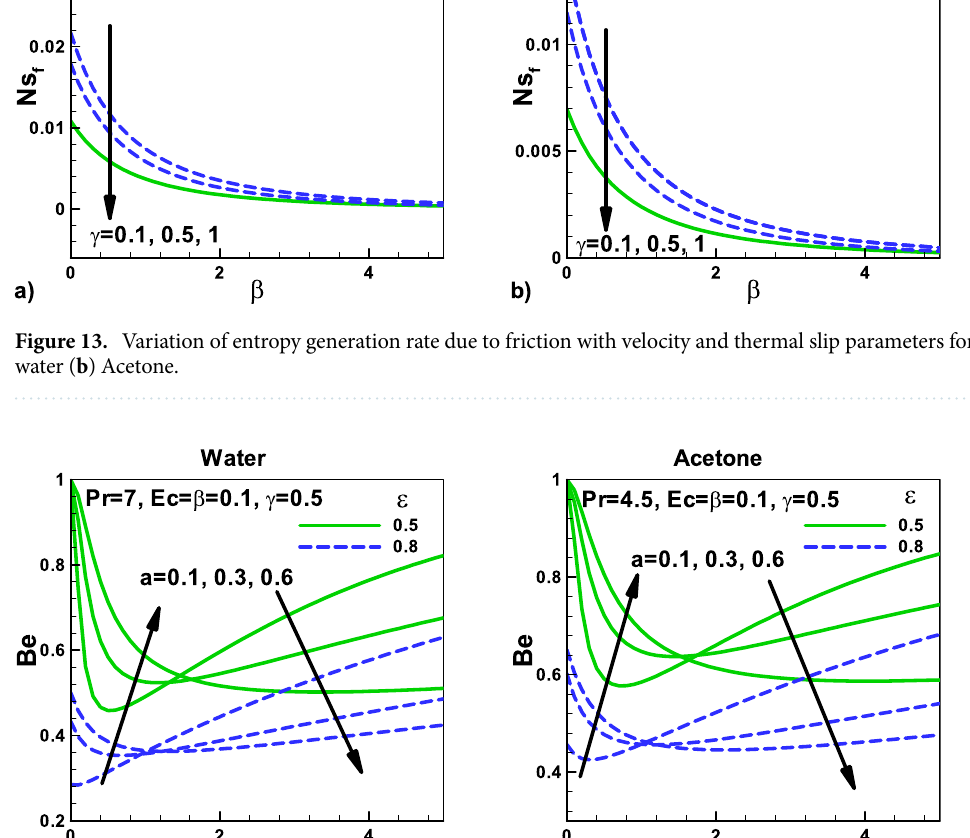
total entropy generation rate N sh are also increasing, as displayed in Fig. 10 for water and acetone, respectively. Eckert number Ec also produces heating effects that increase the temperature gradients and increase the entropy generation rates N sh . Figure 12: The variation of entropy generation rate due to fluid friction with magnetic parameter M and needle size a for (a) water (b) acetone. The effect of variation in composite velocity and the increase in the size of the needle will increase entropy generation due to fluid friction. The impact of Eckert number Ec on the total entropy generation rate N sf is also displayed with thermal slip parameter and with velocity slip β , in Figs. (a) and (b) for water and acetone, respectively. Figure 13: Variation of entropy generation rate due to velocity slip β and thermal slip parameters for (a) water and (b) acetone. The effect of the magnetic parameter with composite velocity for the same needle involved. The impact of Eckert number Ec on the entropy generation rate N sf due to fluid fraction with velocity slip is displayed in Fig. 12a,b for water and acetone, respectively. Eckert number Ec also produces heating effects that increase the temperature gradients and decrease the entropy generation rates due to fluid fraction N sf . Figure 14: Variation of Bejan number with magnetic field and velocity ratio parameter at different positions for (a) water and (b) acetone. The variation of Bejan number Be with relevant parameters for acetone and water is depicted in Figs. 13 and 14, respectively. It shows the relative dominance of irreversibility due to heat transfer Be < 0.5 , the irreversibility due to fluid friction dominates, and for 0.5 < Be 1 , the and fluid friction. For 0 ≤ ≤ irreversibility due to heat transfer dominates. In Fig. 13a,b, the Bejan number Be is plotted for different needle sizes using acetone and water as working fluids. Be varies between 0.1 and 1 that shows the dominance of irre- versibility due to fluid friction for smaller values of γ and the dominance of irreversibility due to heat transfer for larger values of γ. When the needle velocity increases, the irreversibility’s due to heat transfer decrease. As a result, the Be also increases when magnetic parameter M is between 0 and 1.And Be decrease for M greater than 1. The viscous dissipation also helps in increasing the temperature, which increases the irreversibility due to heat transfer. Consequently, the Bejan number Be also increases Fig. 14a,b. Due to the higher Prandtl number